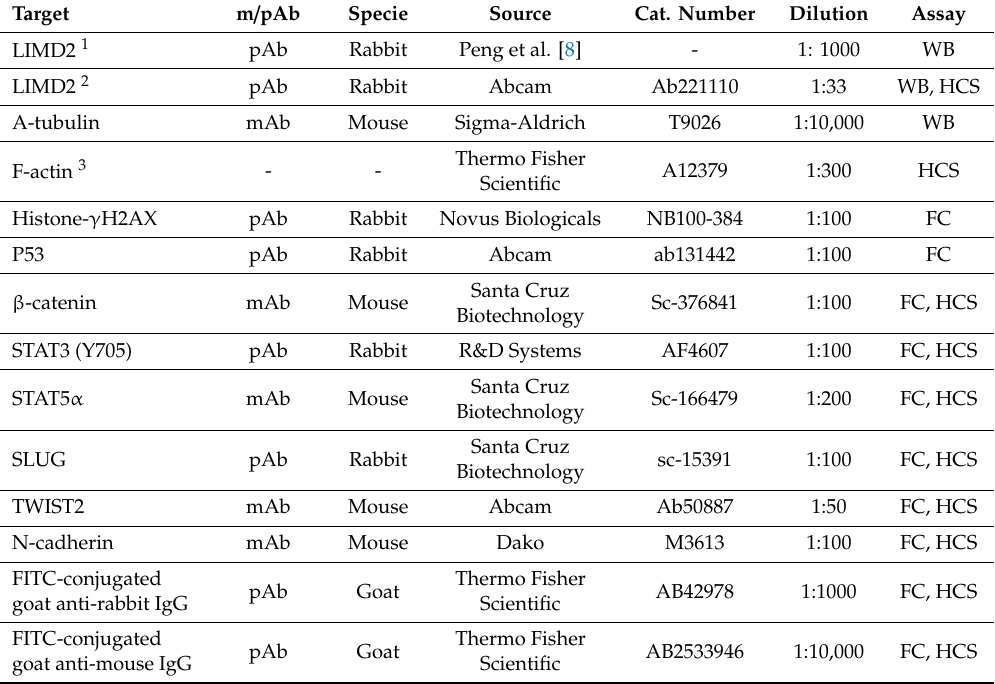
Table 2. Antibodies specifications and working solutions used in this